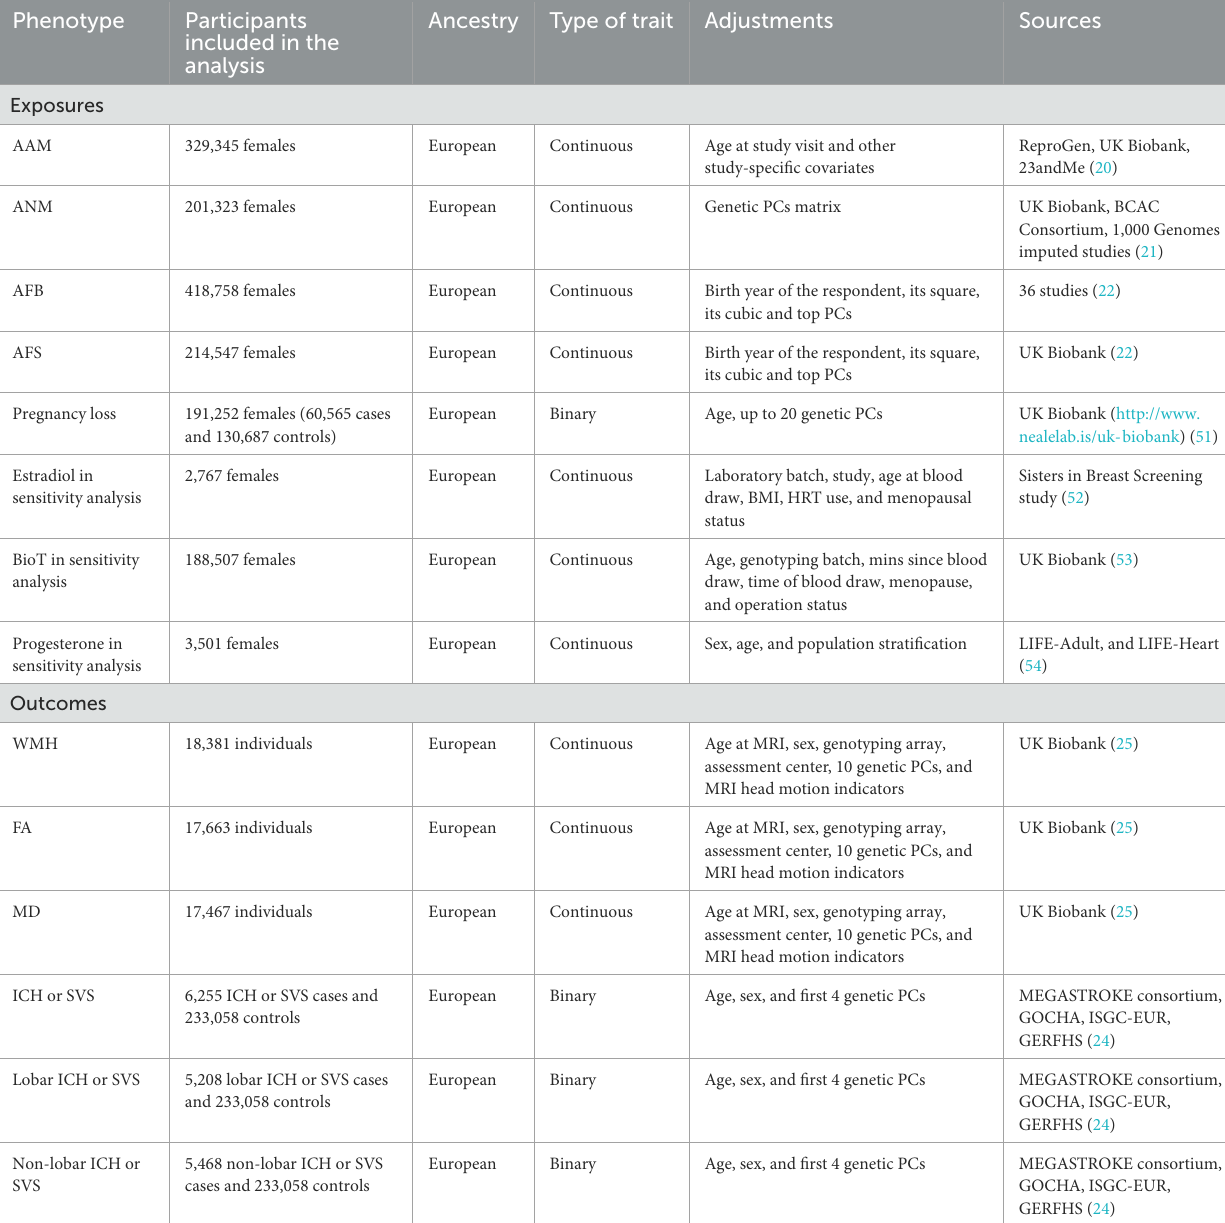
TABLE 1 Data sources used in the MR analyses for the current